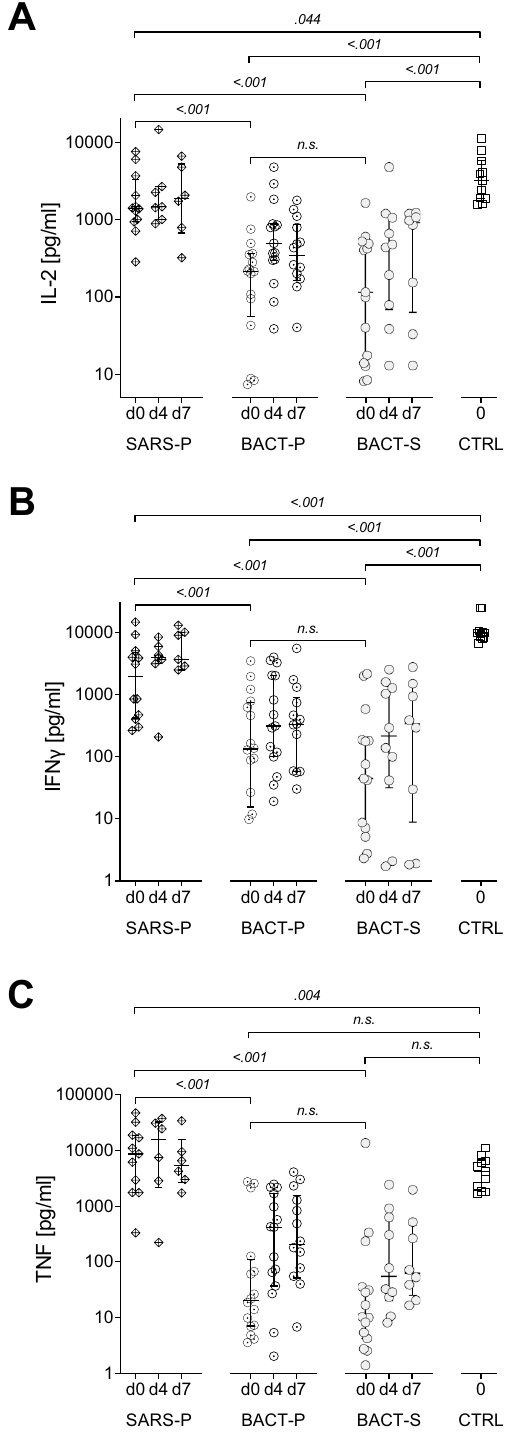
Figure 1. Cytokine concentrations after stimulation with pokeweed mitogen (PWM). Concentrations of IL-2 ( A ), IFN-γ ( B ) and TNF ( C ) were measured in whole blood samples obtained from patients with severe COVID-19 (SARS-P, d0: n = 12, d4: n = 7, d7: n = 7), from patients with sepsis resulting from bacterial pneumonia (BACT-P, d0: n = 16, d4: n = 15, d7: n = 14), from patients with sepsis resulting from bacterial origin other than pneumonia (BACT-S, d0: n = 15, d4: n = 10, d7: n = 8) and from healthy volunteers (CTRL, n = 11), after PWM stimulation (5 µg/ml) for 48 h at day 0, day 4 and day 7. n.s. ; non-significant, two-way ANOVA and Holm-Šídák